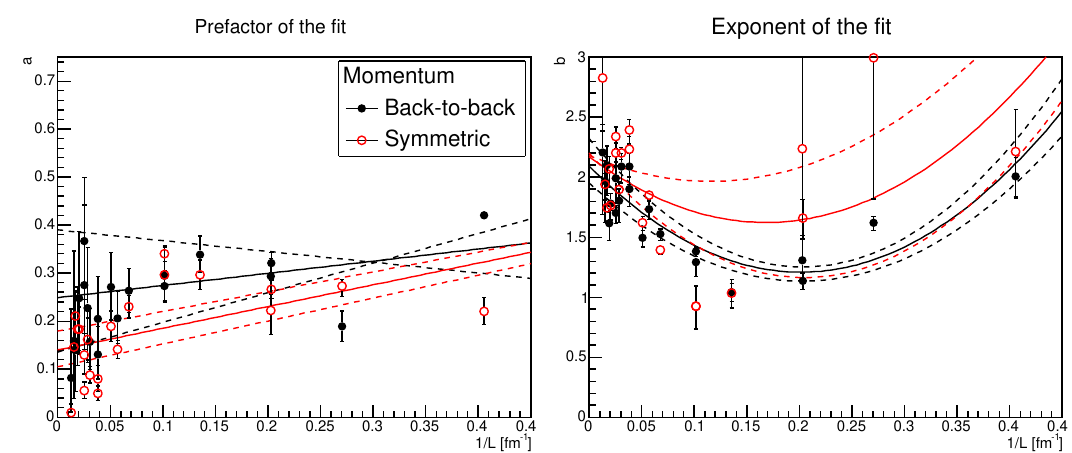
Figure 3: The fit parameters of (4) in 3 dimensions, together with a fit for the vol- ume dependence. For the prefactor the fit is linear in the inverse lattice extent, and quadratic for the